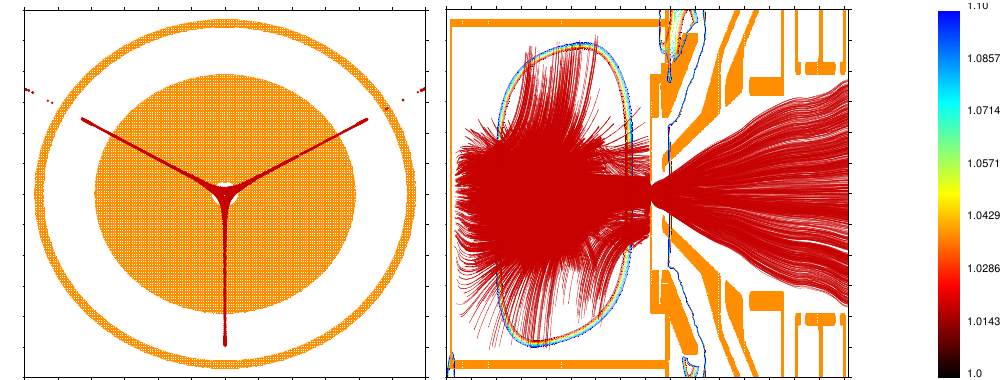
Figure 9. Left: projection of initial positions of trajectories in longitudinal direction at x = 0.4m. Right: trajectories in a transverse projection, at 6 cm with 1.0T to 1.1T are shown together with the